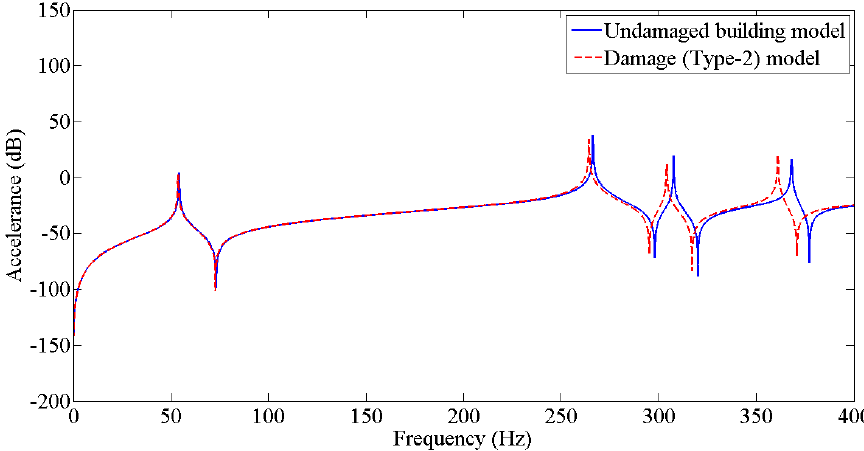
Figure 7. Prediction of structural dynamic behavior of building model under undamaged and damaged (Type − 2) conditions through FRFs.